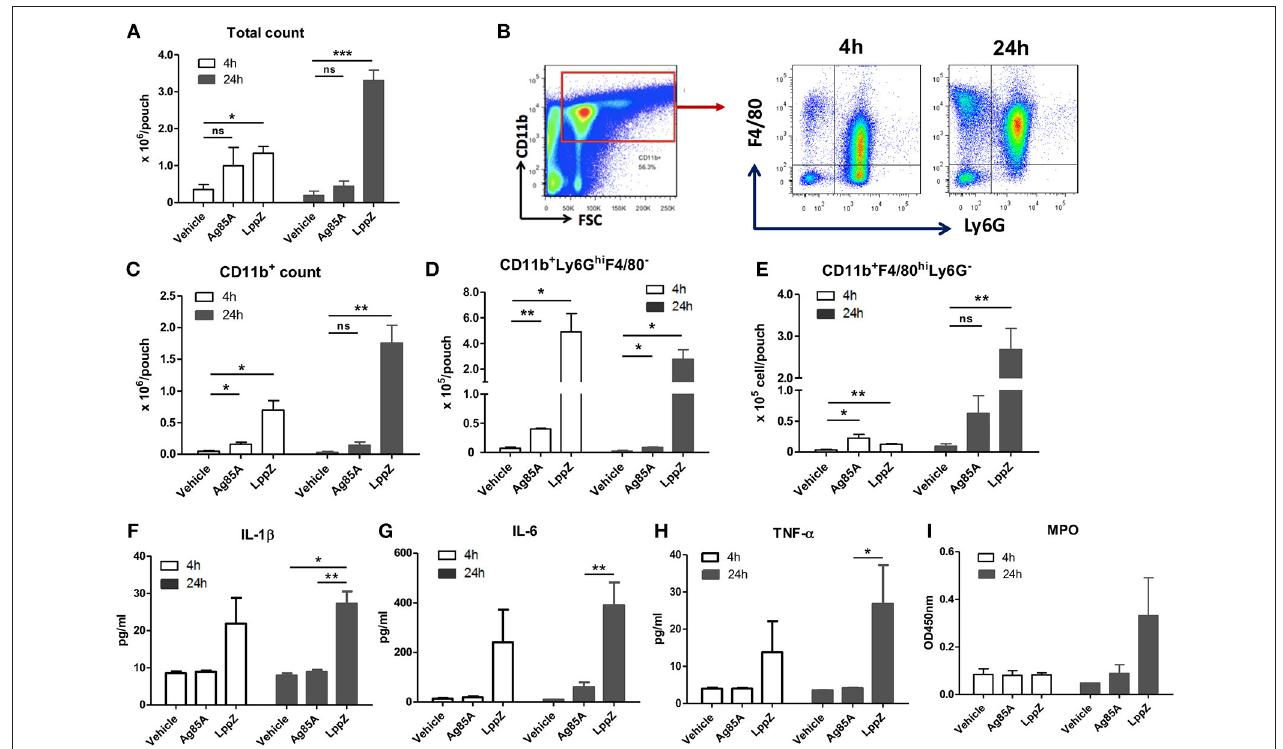
FIGURE 2 | LppZ recruits innate cells and induces pro-inflammatory cytokine production in the murine air pouch model. After injecting CMC (vehicle), LppZ (LppZ) or Ag85A (Ag85A) recombinant protein in the pouches, mice were sacrificed at 4h and 24h. Cells in the pouches were collected. (A) Total cell numbers recruited in the pouches. (B) Representative graphs showing the gating strategy for analysis of infiltrating cell subsets. The absolute numbers of CD11b + cells (C) , CD11b + Ly6G hi F4/80 − neutrophils (D) and CD11b + Ly6G − F4/80 + macrophages (E) were analyzed by flow cytometry. The levels of IL-1 β (F) , IL-6 (G) , TNF- α (H) , and myeloperoxidase (MPO) (I) were measured in the exudates ( n = 3–6 mice per group). * p < 0.05, ** p < 0.01, *** p <